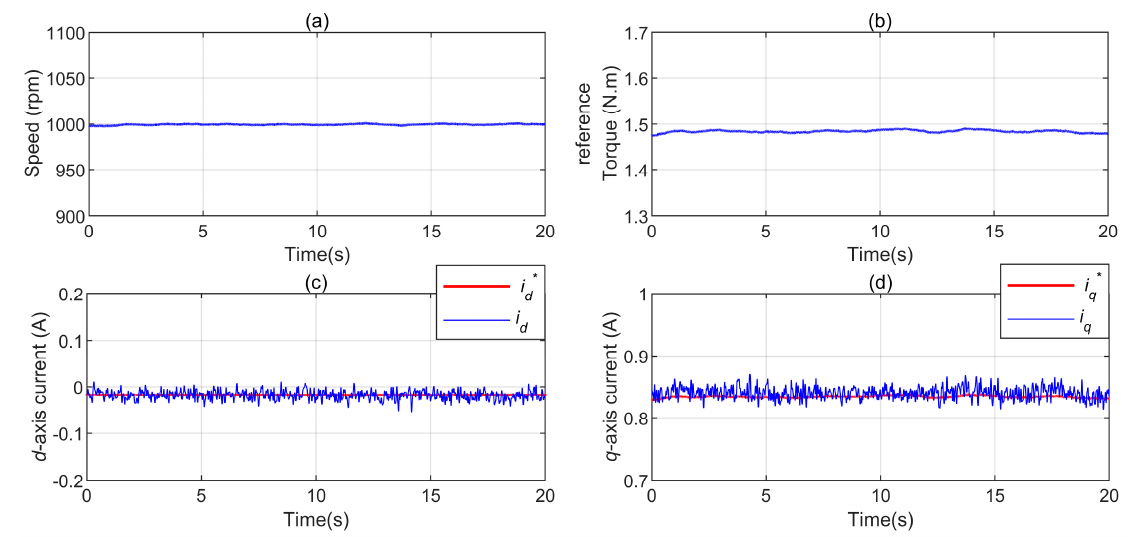
Figure 6. The experiment result: ( a ) machine speed; ( b ) reference torque; ( c ) d-axis reference current and d-axis stator current; ( d ) q-axis reference current and q-axis stator current.